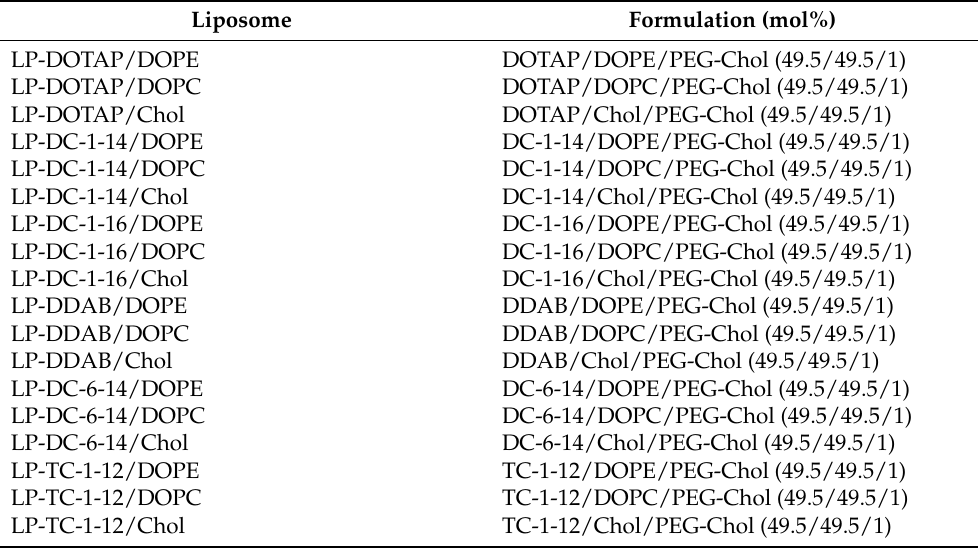
Table 1. Liposomal formulation for mRNA transfection with a lipid-ethanol